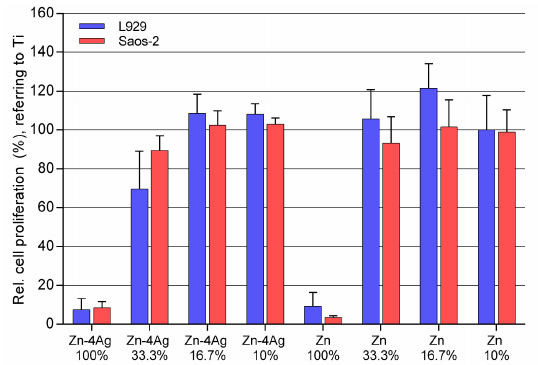
Figure 8. Influence of different concentrations of Zn-4Ag alloy and pure Zn extracts on the cell proliferation of L929 and Saos-2 determined by BrdU assay. Ti-6Al-4V alloy was used as negative control and was set to 100%. Means of two independent experiments are shown with respective standard